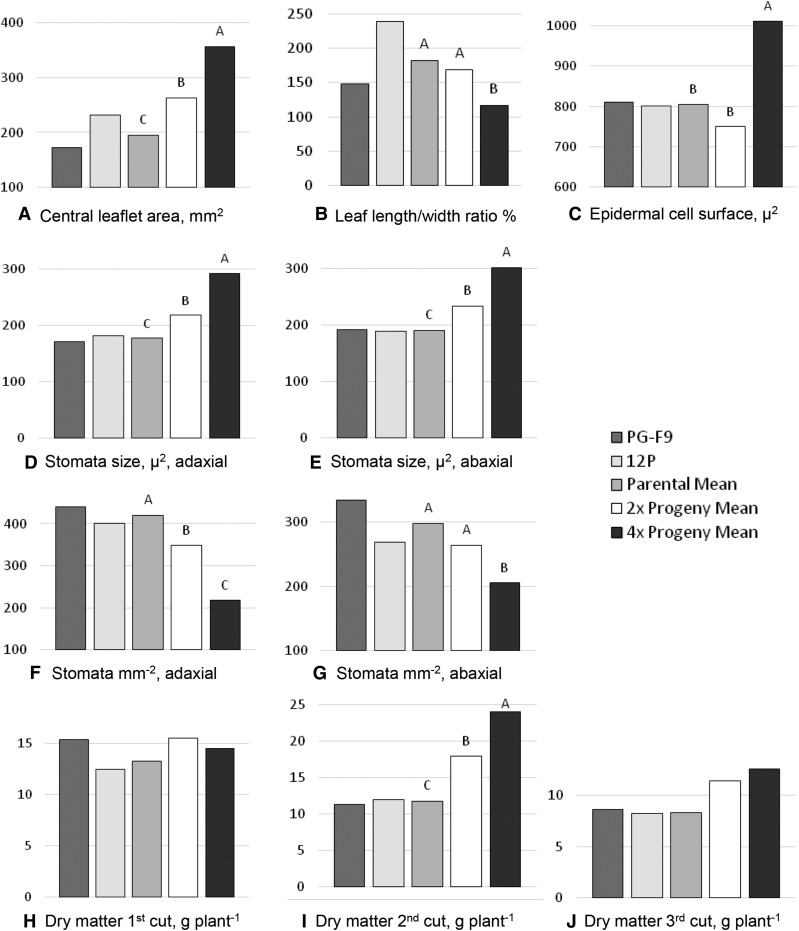
Leaf morphology and dry matter yield of parental genotypes, their mean, and comparisons of the mean with those of 2x and 4x hybrids (three genotypes per ploidy level). (A) Central leaflet surface area (n = 20 per genotype). (B) Ratio between length and width of the central leaflet (n = 20 per genotype). (C) Surface area of epidermal cells (n = 20 per genotype). (D) and (E) Size of stomata of adaxial and abaxial leaf epidermis, calculated from their axes length. (F) and (G) Number of stomata per mm2 of adaxial and abaxial leaf epidermis (n = 20 per genotype), (H)–(J) Dry matter per plant at each of three consecutive cuts at 10% flowering (n = 2–6 per genotype). Different letters above columns indicate significant differences at P < 0.05 (see text for details on statistical analyses).